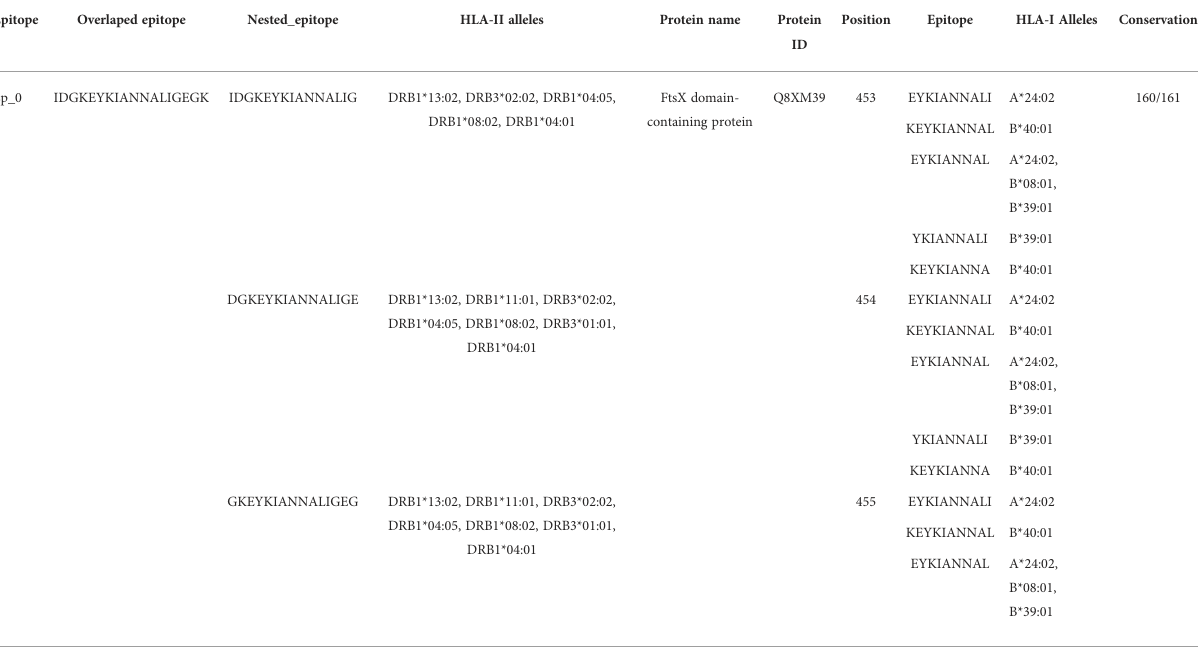
TABLE 2 Characteristics of the predicted epitopes selected for the construction of the multi-epitope protein. Epitope Overlaped